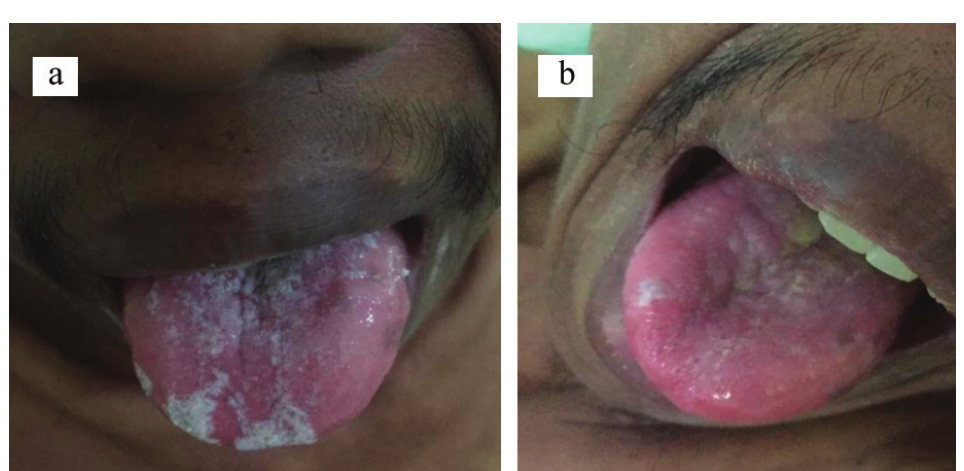
Fig. 4. Treatment progress on the sixth day when pseudomembrane thinning out (4a) and the progress on the tenth day when pseudomembrane disappeared